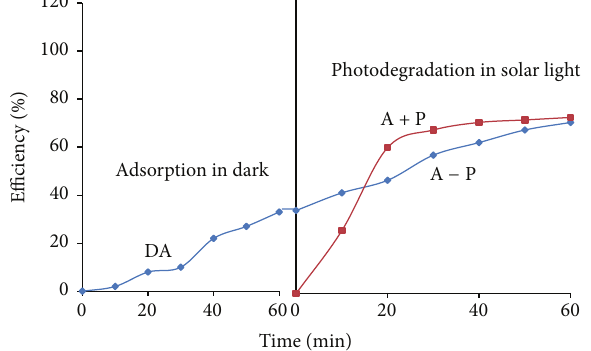
Figure 8: Photodegradation of MB under different reaction condi- tions: [MB] = 6.0 × 10 −5 moldm −3 , catalyst dosage = 50 mg/100mL, pH = 5, temperature: 30 ± 0.5 ∘